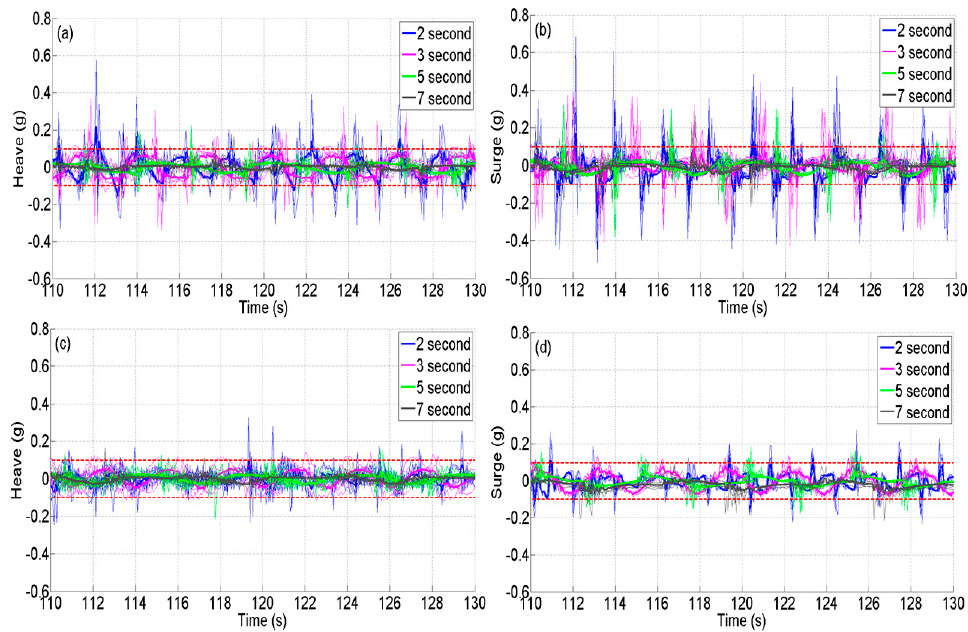
Figure 5. Twenty-second time slice of raw acceleration versus time: ( a ) Narrow Pontoon Heave Acceleration; ( b ) Narrow Pontoon Surge Acceleration; ( c ) Wide Pontoon Heave Acceleration; and ( d ) Wide Pontoon Surge Acceleration. The horizontal red dashed line indicates the Safe Motion Limit of 0.1